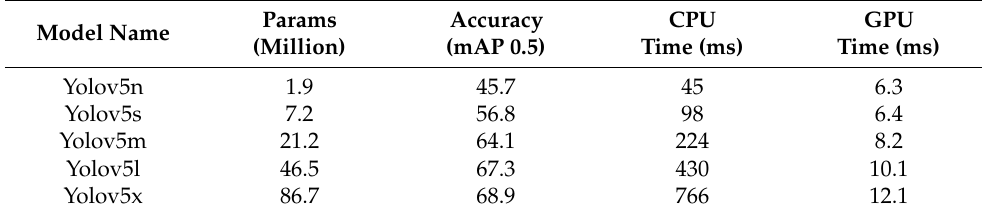
Table 1. An overview of YoloV5